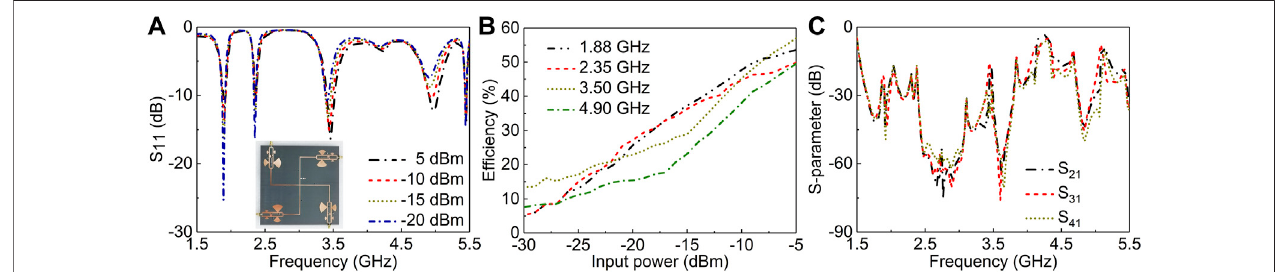
FIGURE 3 | (A) Measured re fl ection coef fi cient of the proposed recti fi er at different input power levels for a load resistance of 2000 Ω . (B) Measured RF-DC conversionef fi ciencyoftheproposedrecti fi erversusinputpowerlevelaforaloadresistanceof2000 Ω . (C) MeasuredS 21 ,S 31 ,S 41 oftherecti fi erarrayataninputpower of − 10 dBm.